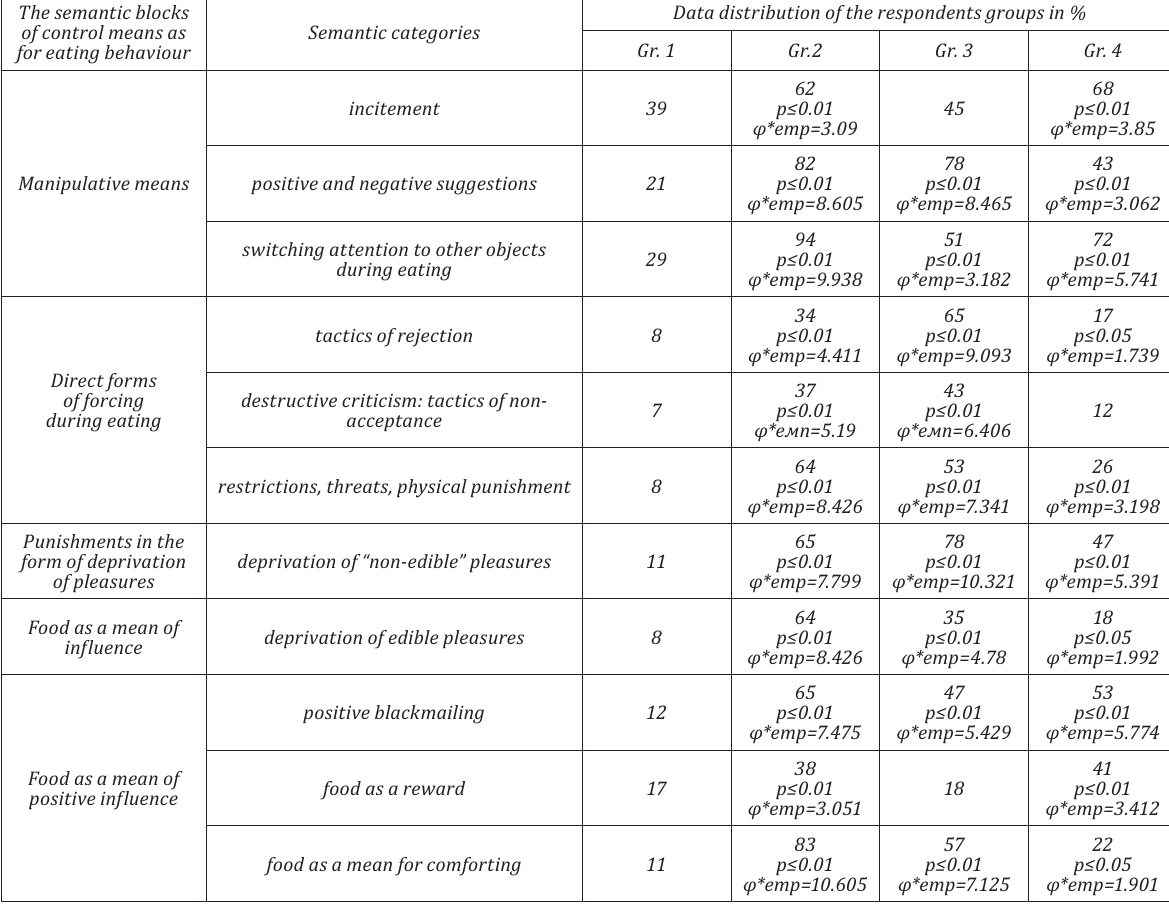
*The table shows the statistical differences between the indicators of group 1 (satisfied with their weight) and other studied